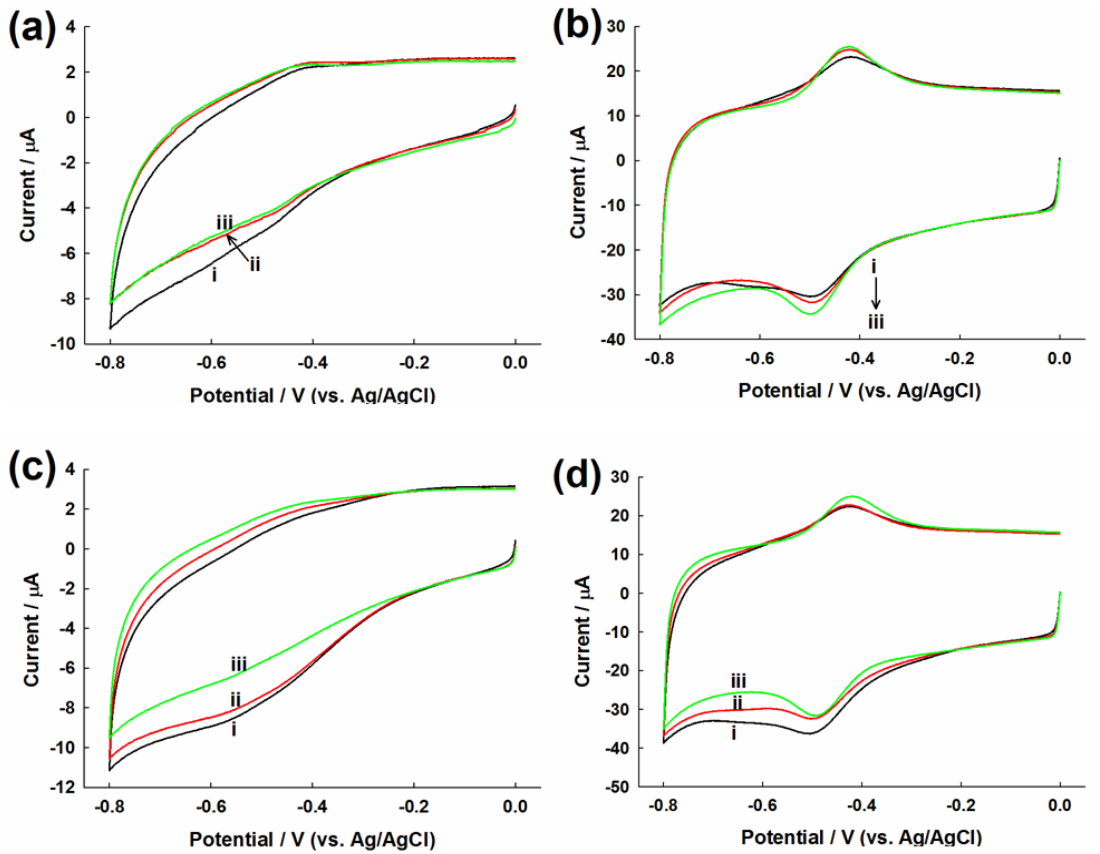
Figure 3. CVs of ( a , c ) Nafion/graphene-GOx/GCE and ( b , d ) Nafion/MWCNT-GOx/GCE in ( a , b ) nitrogen and ( c , d ) air-saturated PBS containing (i) 0 mM; (ii) 1 mM and (iii) 8 mM glucose. Scan rate: 100 mV s − 1